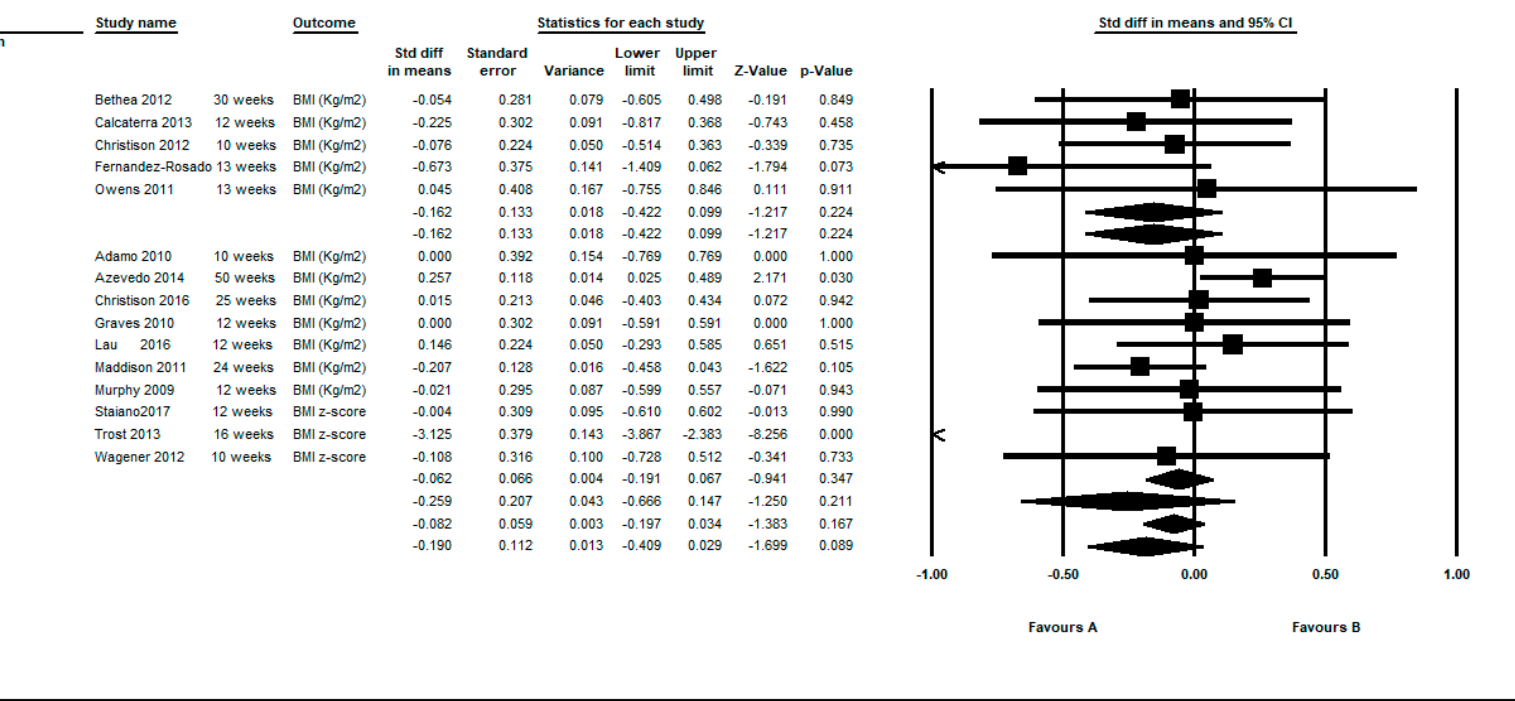
Figure 3. Pre-post intra-group difference in BMI in the group intervened with active video games. All measurements in the longest follow-up.